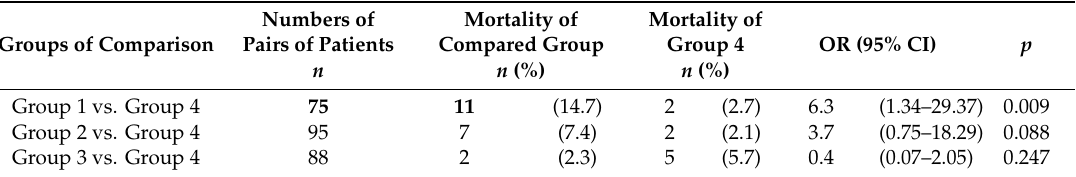
Table 2. Comparison of the mortality outcomes in the propensity-score matched cohorts of the elderly patients with femoral fractures in group 1–3 vs. group 4 patients.